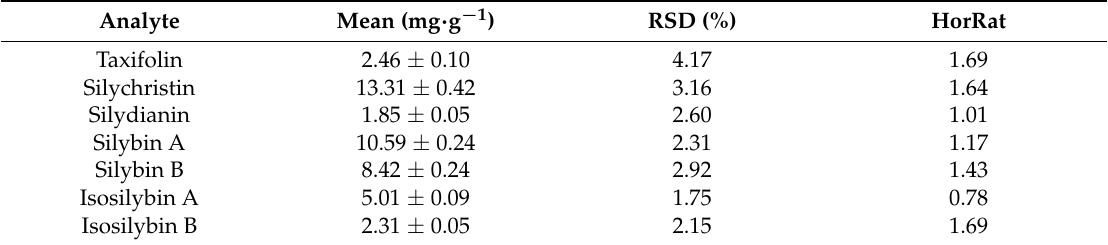
Table 2. Repeatability precision results summary for the quantification of the different analytes in standardized commercial silymarin preparation from milk